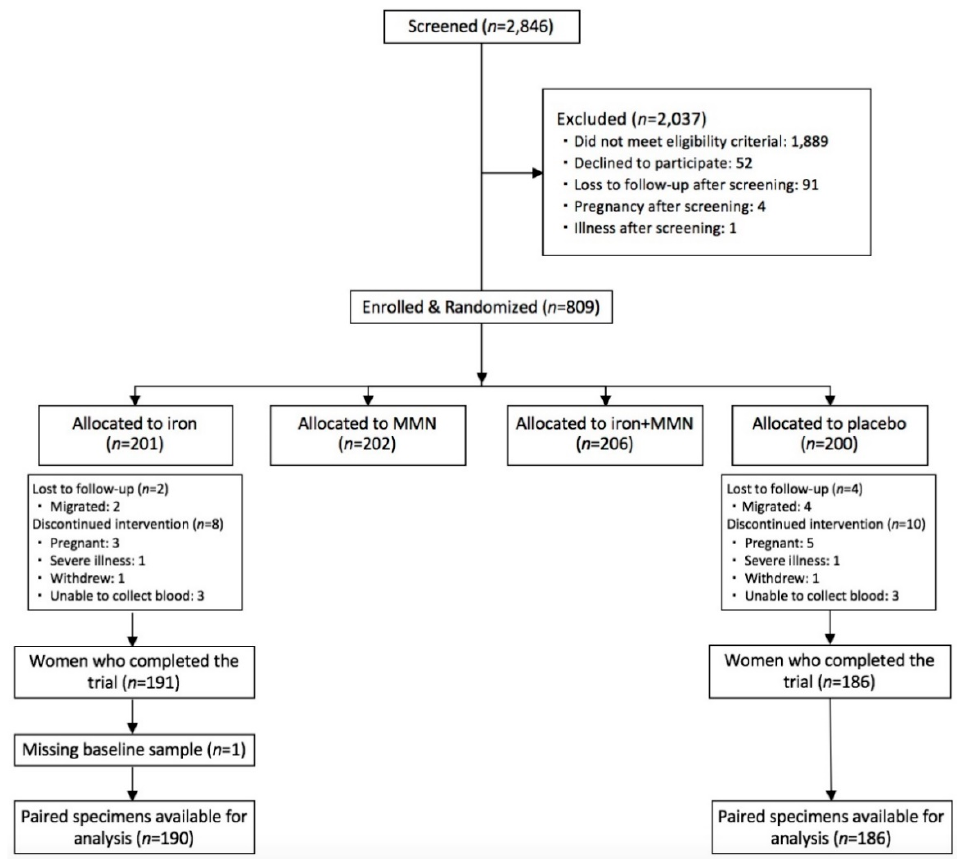
Figure 1. Flow chart of enrolment from the trial for women whose specimens were included in the current study. MMN, multiple micronutrients.